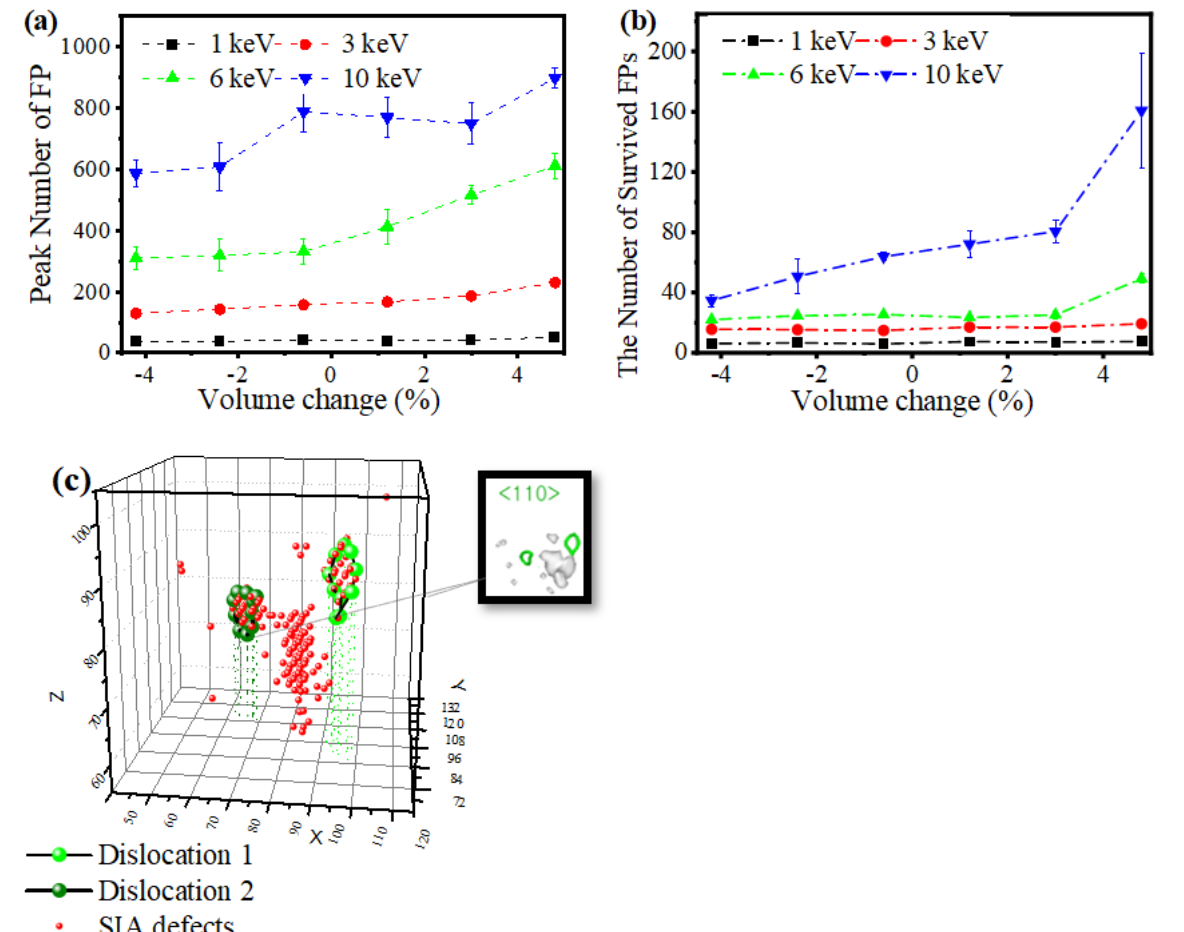
Figure 4. ( a ) The peak number of FP under strain conditions for primary knock-on atom (PKA) energies (1, 3, 6, and 10) keV as a function of hydrostatic strain ( b ) number of survived FP after 20 ps, the black–box shows the ½<111> dislocation formation for <110> displacement collision direction at 10 keV. The error bar denotes the SEM over the selected samples ( c ) Analysis of the ½<111> dislocation configuration and defect formation.